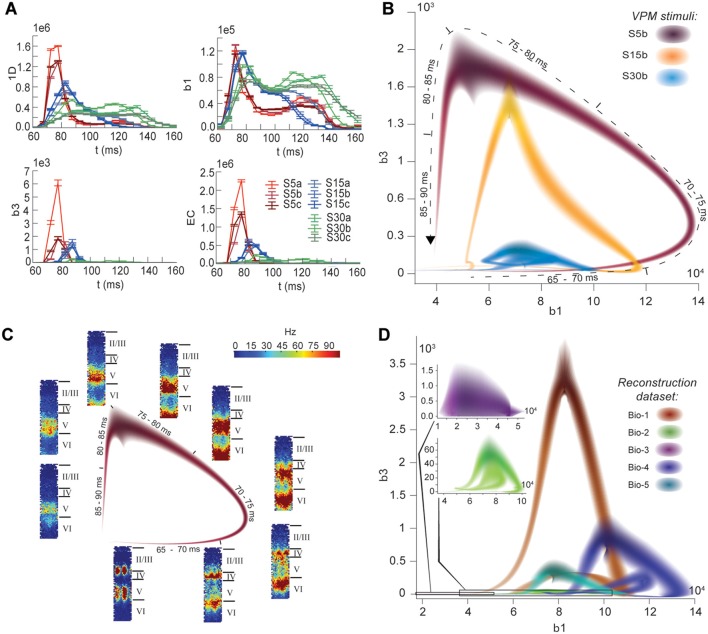
(A) Number of edges, β1, β3, and Euler characteristic of the time series of TR graphs in response to the stimulus patterns shown in Figure 4 (mean and SEM of 30 repetitions of each stimulus). (B) Trace of the time series of β1 against β3 for three of the stimuli. Shading of colors indicates Gaussian profiles at each time step with means and standard deviations interpolated from 30 repetitions of each stimulus. (C) Trace for one of the stimuli in B, along with the mean firing activity at different locations of the microcircuit during time steps of 2 ms. (D) Like (B), but for TR graphs of Bio 1-5, in response to stimulus S15b.